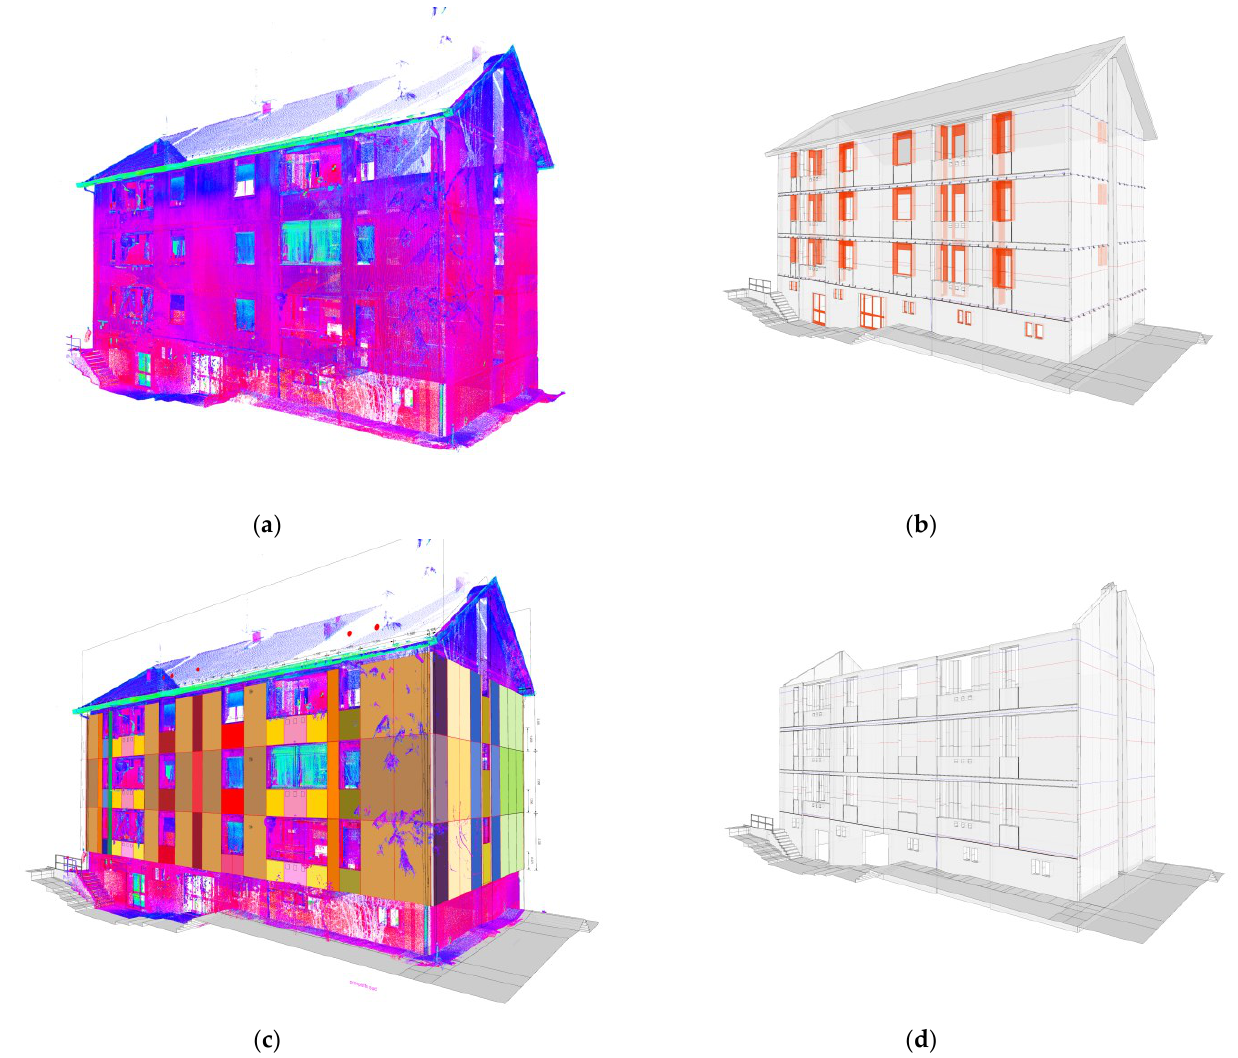
Figure 8. Three-dimensional modelling of the case study: ( a ) scan-to-BIM model and laser scans; ( b ) as-found model; ( c ) as-designed BIM model; ( d ) anchoring system.